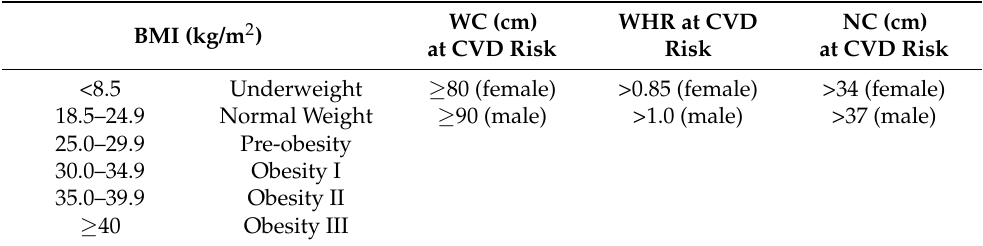
Table 1. Limits and classifications of the risk of cardiovascular diseases for diverse parameters used in this study